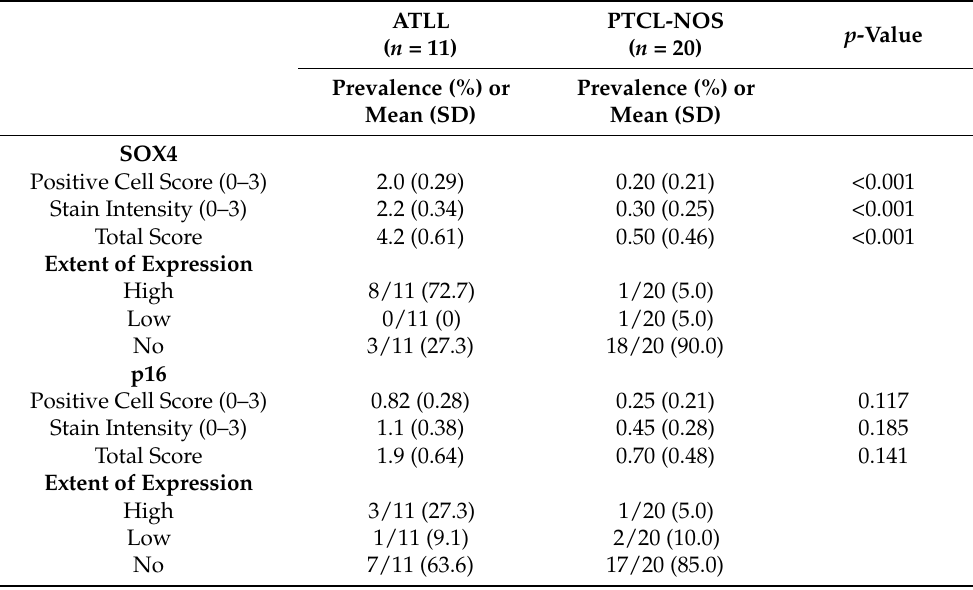
Table 1. SOX4 and p16 immunohistochemical staining and scores of patients with adult T-cell leukemia/lymphoma (ATLL) and peripheral T-cell lymphoma, not otherwise specified (PTCL-NOS).